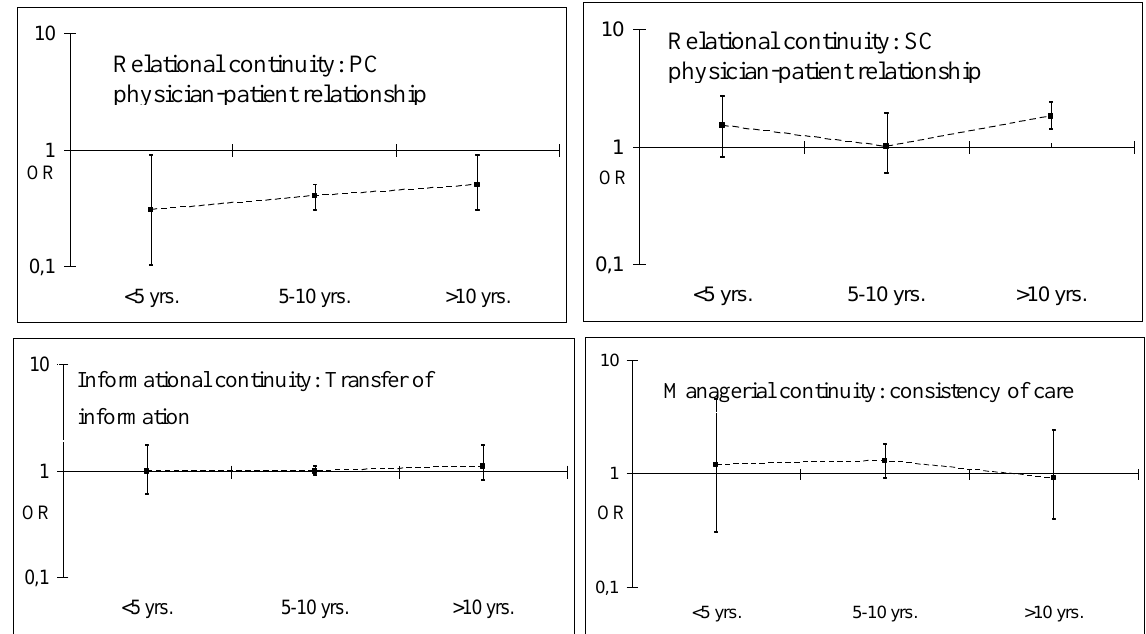
Figure 1. Odds Ratio of adjusted relationships between perceptions of continuity of care and immigration status according to the length of stay in Spain. Logistic models adjusted for healthcare area, age, sex, level of education, and self-perceived health status. Reference category: